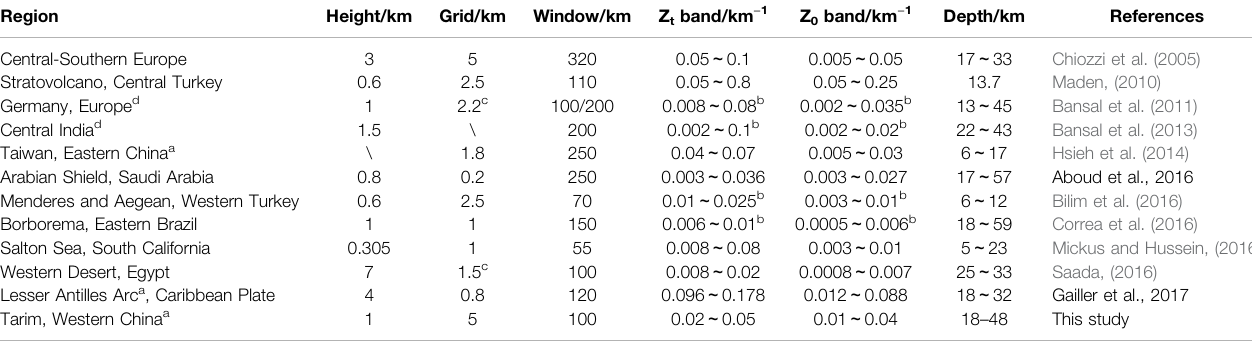
TABLE 1 | Previous Curie-point depth estimations using the centroid approach based on aeromagnetic data.